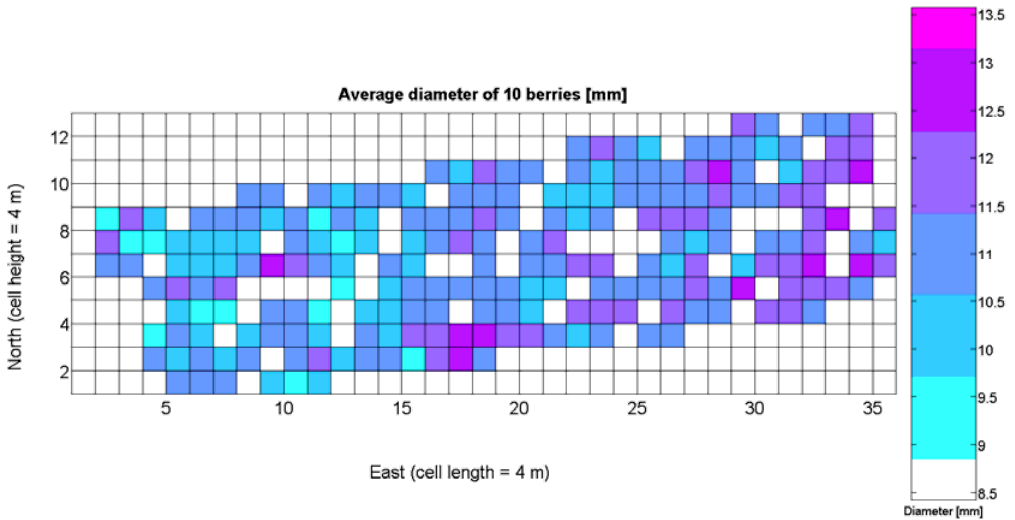
Figure 14. CB map of berry average diameter (mm).